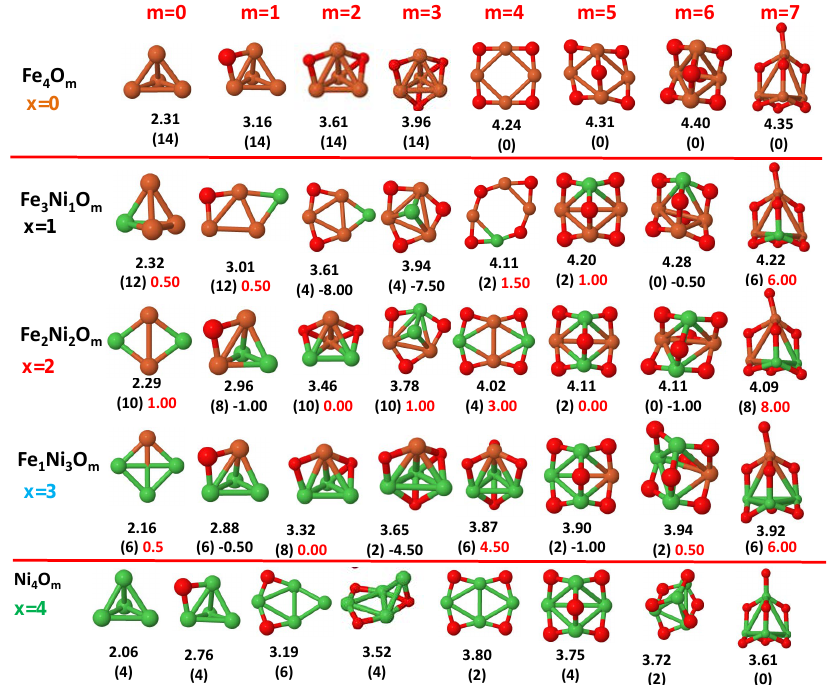
Figure 9. Putative global minimum structures of Fe 4 − x Ni x O m , x = 0–2, m = 1–6. Numbers below structures are the binding energy per atom (in eV), numbers in parentheses are the magnetic moment (in µ B ) and the third number (when present) is the excess magnetic moment (in µ B ) defined in Equation (2). Fe atoms in brown color, Ni atoms in green and oxygen atoms in